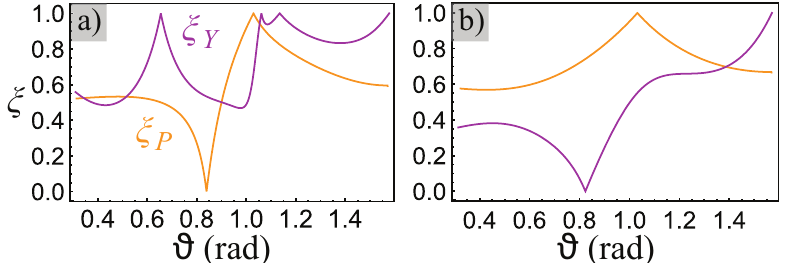
Figure 3. Polarization mixing factor for linear (magenta line) and angular (orange line) in reflection ( a ) and transmission ( b ) configurations. Here, we consider case (1) and assume the linear 45 ◦ polarization of a Gaussian beam. Here, ξ Y and ξ P correspond to PM factors for the linear and angular IF shifts, respectively.